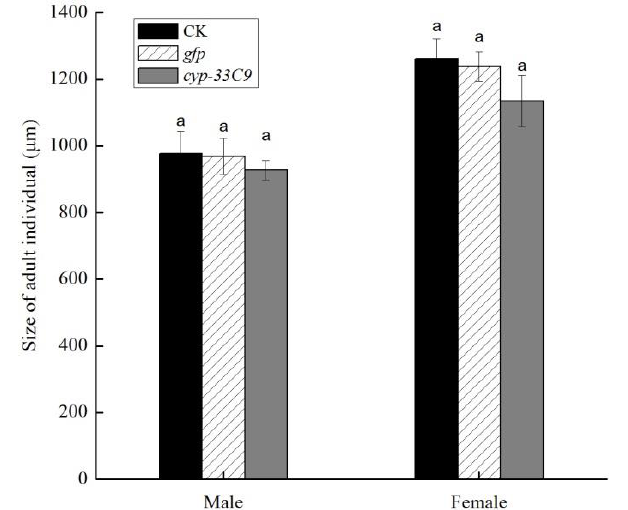
Figure 4. Effects of RNA interference on individual body length of Bursaphelenchus xylophilus . The bars indicate standard deviation, and different letters within a gender indicate significant differences ( p < 0.05), according to Tukey’s test, among the treatments.